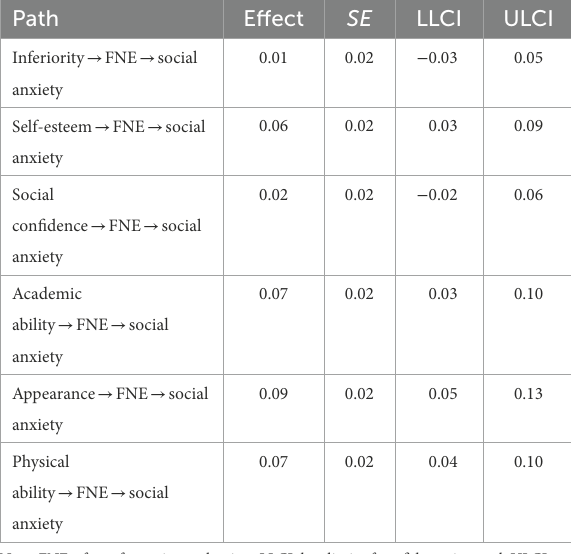
TABLE 4 Bootstrap test for indirect